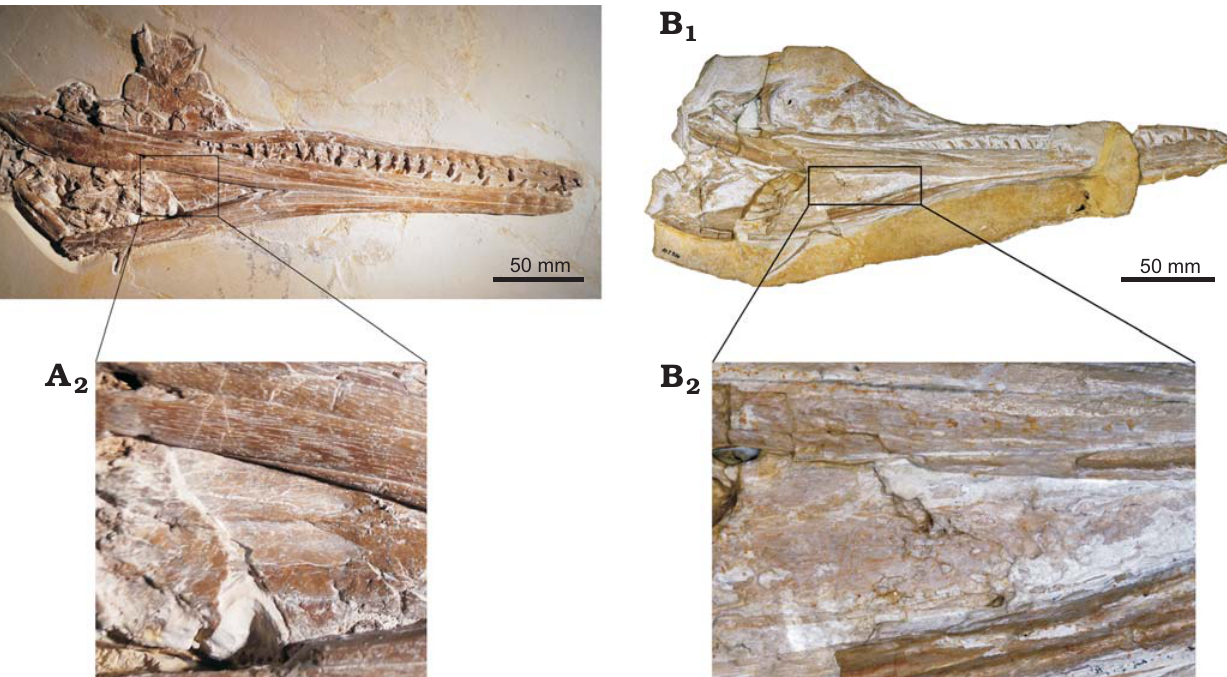
Fig. 9. Comparative images showing the ventral side of the skull and a close-up of the palatal region of metriorhynchid thalattosuchians Cricosaurus bambergensis sp. nov. (NKMB-P-Watt14/274, A ) from the late Kimmeridgian of Wattendorf (southern Germany) and Cricosaurus elegans (BSPG AS I 504, B ) from the lower Tithonian of Dating (southern